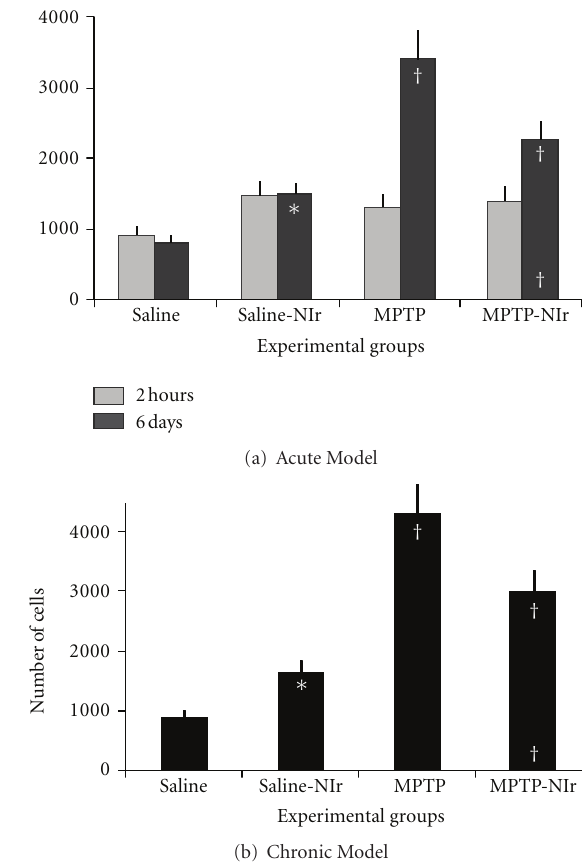
Figure 2: Graphs showing number of Fos + cells in the STN of the four groups in the acute (a) and chronic (b) MPTP mouse models. Columns show the mean ± standard error of the total number of cells in each group. In (a) and (b), † represents P < 0 . 001 and ∧ represent P < 0 . 01 significant di ff erence in cell number between di ff erent groups (using Tukey-Kramer multiple comparison test). The symbols at the top of each column represents di ff erences with the saline group, while the symbols at the bottom of MPTP-NIr group column represent di ff erences with the MPTP group.